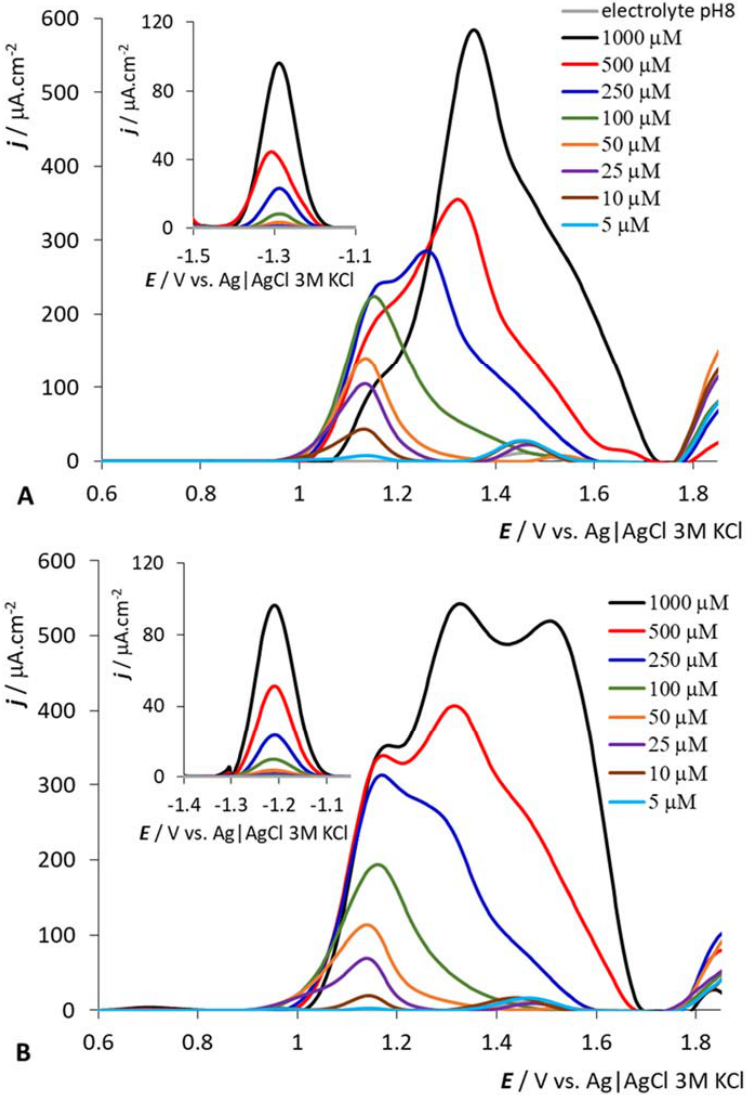
Figure 5. Concentration dependencies of HOOC-CoSAN ( A ) and (HOOC)2-CoSAN ( B ), at pH 8, GCE. See the captions in the panels for concentration identification.